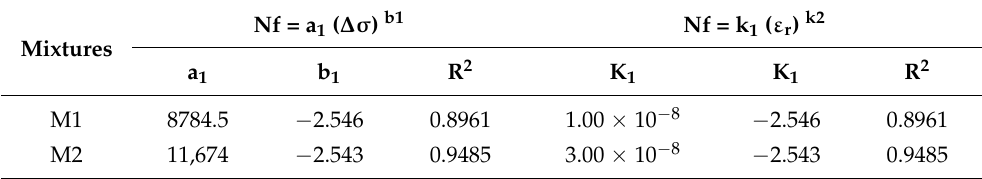
Table 7. Regression parameters of the fatigue life curves of the